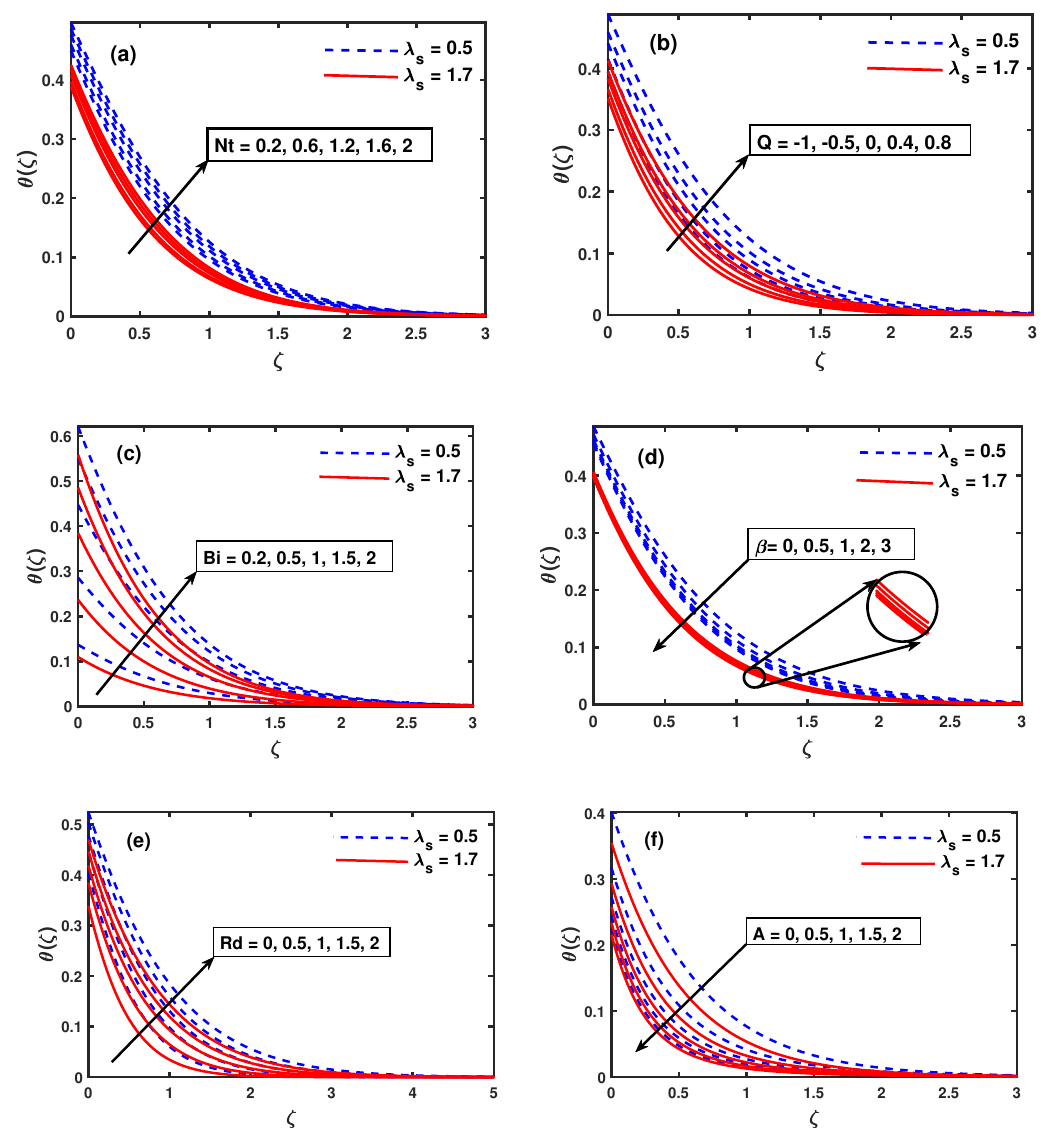
Figure 4. Fluctuation of temperature profile ( θ ( ζ ) ) along with thermophoresis ( Nt ) ( a ), heat generation/absorption ( Q ) ( b ), Biot number ( Bi ) ( c ), wedge angle ( β ) ( d ), radiation ( Rd ) ( e ), and unsteadiness parameter ( A ) ( f